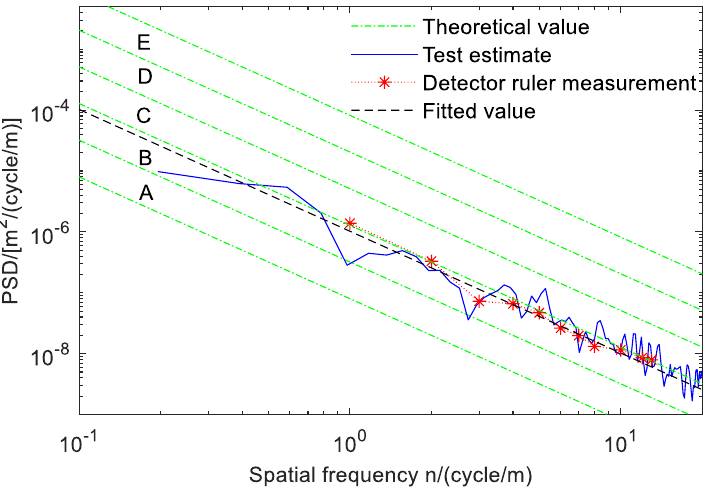
Figure 11. Comparison of theoretical and test values of road PSD.